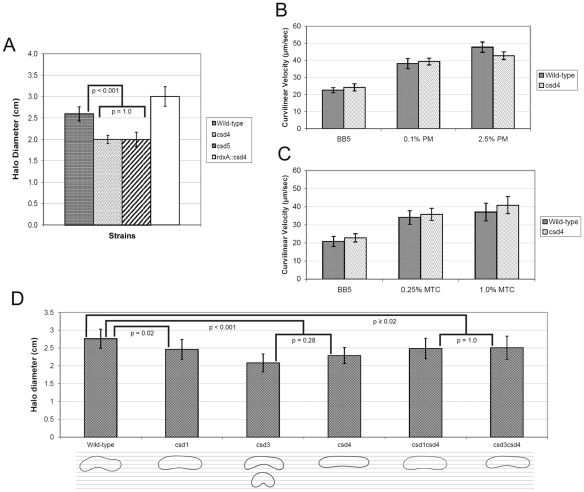
Motility of H. pylori cell shape mutants in soft agar and viscous polymer solutions.A, D) Motility phenotype of indicated strains in soft agar (mean halo diameter ± SD in 0.3% soft agar after four days). Data shown are from one experiment of 17–22 stabs/strain and are consistent with the findings from replicate experiments. Contours representative of each strain's average cell shape (see Figure 3 legend) are shown below panel D and are superimposed on a grid to highlight the slight differences in cell curvature that correlate with motility. p-values were generated using one-way ANOVA with the Bonferroni correction for multiple comparisons. B–C) Velocity of wild-type and the csd4 mutant in broth containing porcine mucus (B) and methylcellulose (C). Data shown are the mean ± SD from measurements of 9–30 cells/strain/condition. No statistically significant differences between wild-type and the csd4 mutant were observed in any condition (p>0.2, Student's t-test with equal variances). Strains used: A) LSH100, LSH122, LSH123; B–C) NSH57, LSH18; D) LSH100, LSH134, NSH152a, LSH146, NSH153a, NSH160a.